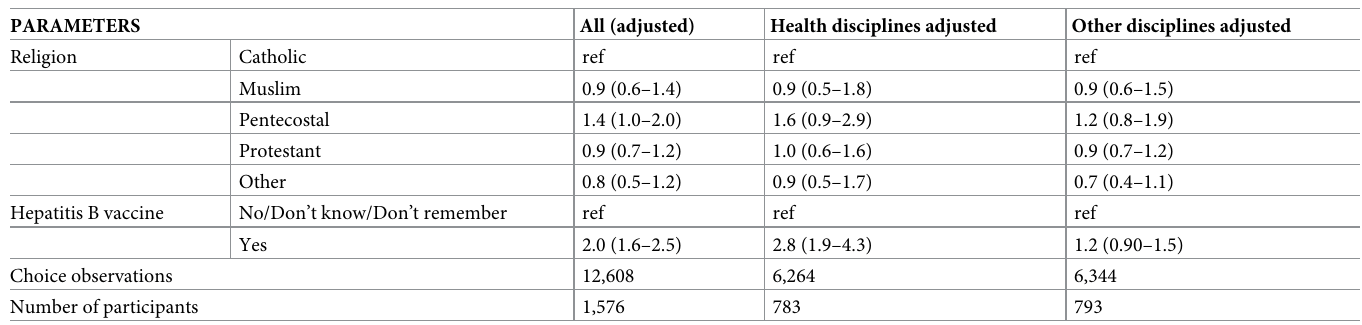
included receipt of hepatitis B vaccine which was associated with 2.8-fold (95% CI 1.9–4.3) dents; and Eastern region of birth (OR 1.9, 95% CI 1.3–2.8). The predicted probability of vaccination willingness was highest (89.0% for students in health disciplines and 81.7% for students from other disciplines) at the highest disease risk (Fig 2, Panel 1). For the lowest disease risk (25 cases reported in a neighboring country), the pre- dicted probability of willingness was 78.1% for health students and 69.3% for non-health stu- dents. At lower levels of disease severity , vaccination willingness was also lower (Panel 2). For each severity parameter, health students expressed a greater willingness than non-health stu- dents. Among the trusted individuals presented (Panel 3), the positive recommendation of family members or friends was associated with the highest predicted probability of vaccination willingness for health students (84.7%) and for non-health students (78.6%), while the negative recommendation of family members and friends was associated with the lowest predicted prob- ability. Among the influential voices presented (Panel 4), the Minister of Health’s recommen- dation was associated with the highest predicted probability for both groups. We observed that advice against vaccination was associated with reduced willingness. With regards to vaccine protection , vaccines with secondary protection were preferred by both groups (Panel 5). While the risk of side effects did not affect willingness for health students, everything except the refer- ent parameter was associated with lower vaccination willingness for non-health students, with the lowest willingness associated with skin rash risk (Panel 6). We did formally compare vacci- nation willingness between groups. Upon testing whether the administration route affected stu- dents’ attentiveness, we did not detect a significant difference between the groups (S1